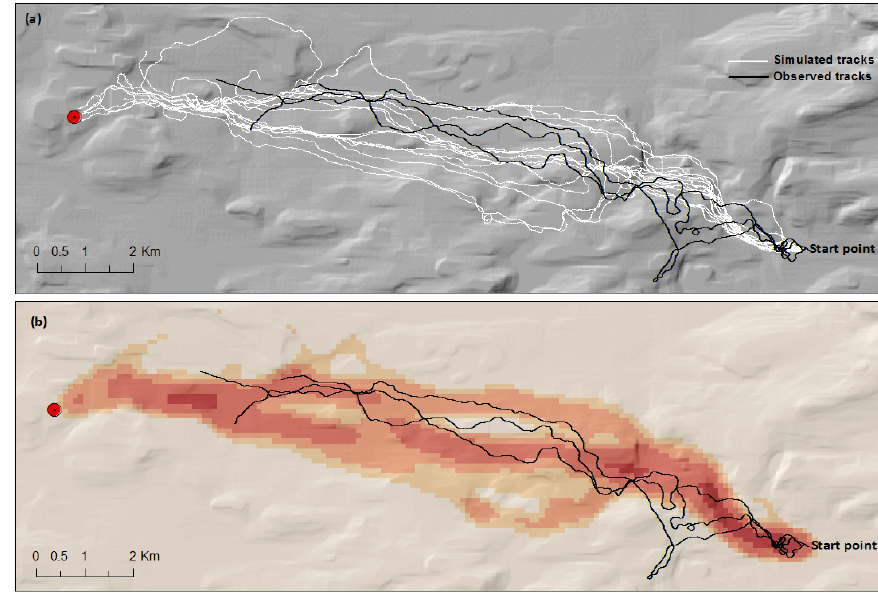
Figure 5. ( a ) Map of simulated and observed (validation) flight tracks of homing pigeons. ( b ) Map of validation flight tracks overlaid on a kernel density surface of locations of simulated tracks of homing pigeons. ISPRS Int. J. Geo-Inf. 2017 , 6 , 27